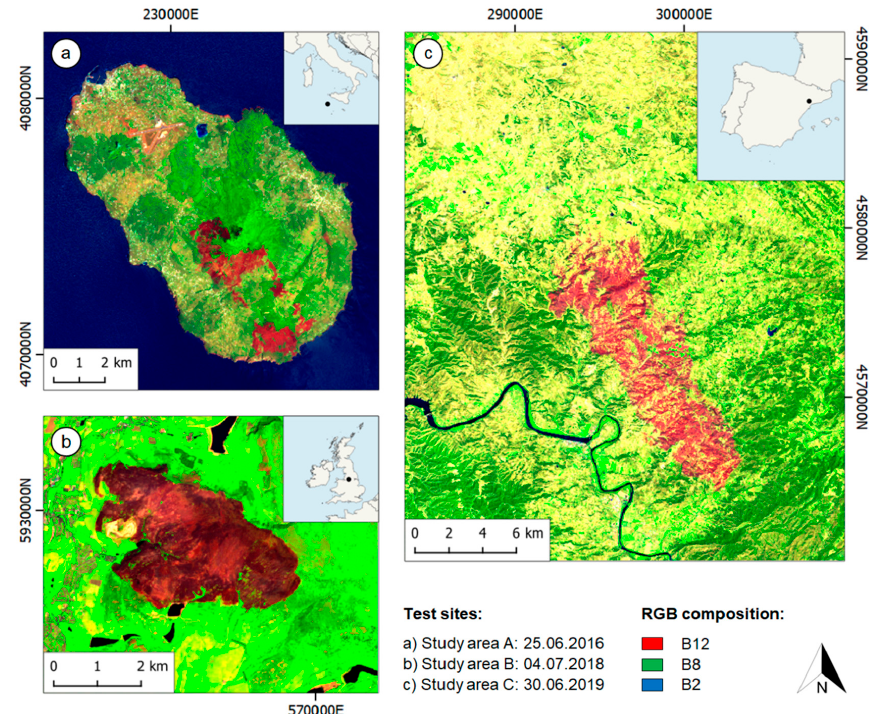
Figure 2. Fire events used for independent testing of the burned area mapping module. Sentinel-2 scenes of the three study areas are presented in a composition of bands B12, B8 and B2; burned areas appear in red. ( a ) Study area in Pantelleria, Italy; ( b ) study area in Mossley, United Kingdom; ( c ) study area near Torre de l’Espanyol, Spain.